Question: State the chart type depicted above.
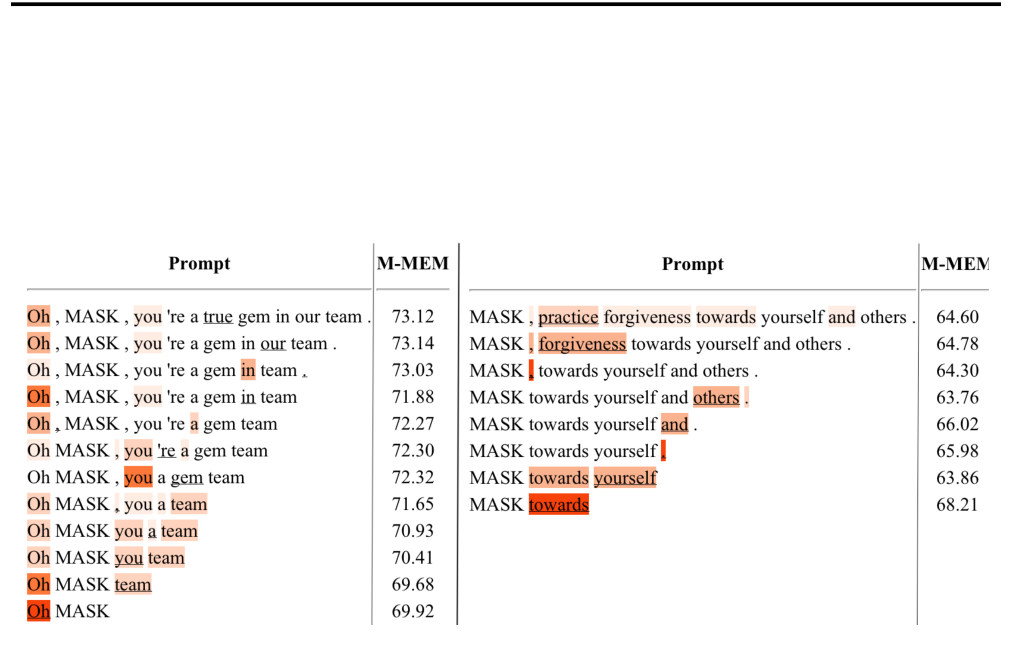
Answer: heatmap